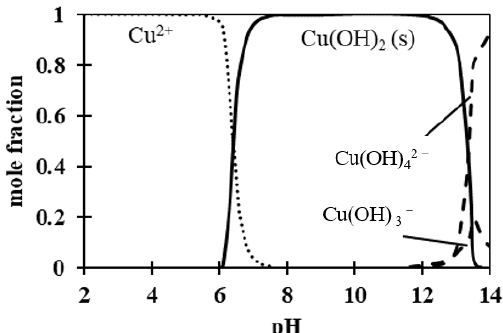
Figure A3. Dependences of Cu(II) forms on the pH value of the aqueous solutions (c 0 = 0.15 mmol dm − 3 ).